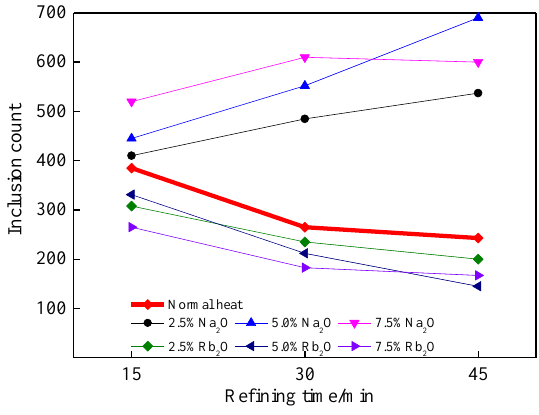
Figure 9. The count of inclusion in experimental steel varies with different refining time.